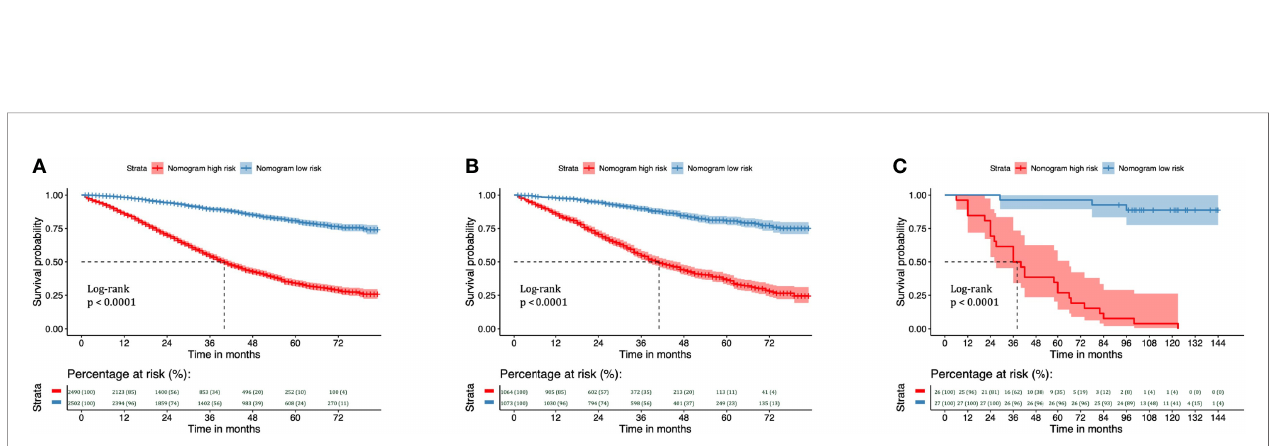
FIGURE 8 | Kaplan – Meier curves of CSS for risk classi fi cation based on the nomogram scores in the training and validation cohorts. Kaplan – Meier curves of CSS for risk classi fi cation based on the nomogram scores (A) in the training cohort, (B) in the validation cohort, and (C) in the 53 patients with EOC treated at Shengjing Hospital. CSS, cancer-speci fi c survival; EOC, epithelial ovarian